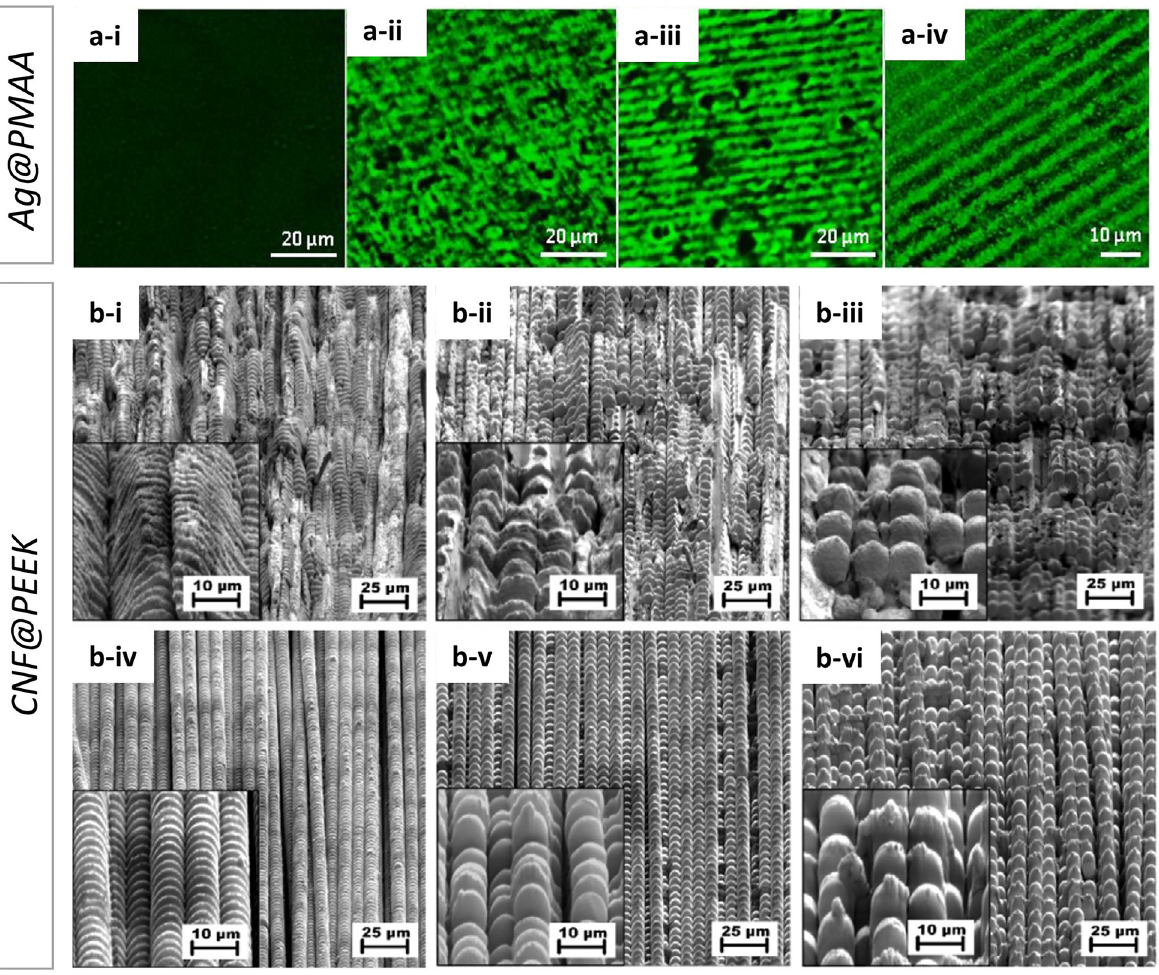
Figure 10: Ag@PMAA: Confocal microscope images Ag@PMAA before (a-i) and after processing by DLIP with increasing number of pulses N : (a-ii) N =1(a-iii) N =3and(a-iv) N =5;CNF@PEEK:SEManalysisofsurfacestructuresfabricatedwithIRatlaser fl uenceof2.86Jcm − 2 ( fi rstrow) and 2 J cm − 2 UV (second row) radiation with increasing N , spatial period Λ and with inserts of higher magni fi cation images: (b-i) Λ = 2 μ m, N = 200, (b-ii) Λ = 4.3 μ m, N = 200, (b-iii) Λ = 8.5 μ m, N = 200, (b-iv) Λ = 2 μ m, N = 200, (b-v) Λ = 4.3 μ m, N = 200, (b-vi) Λ = 8.5 μ m, N =